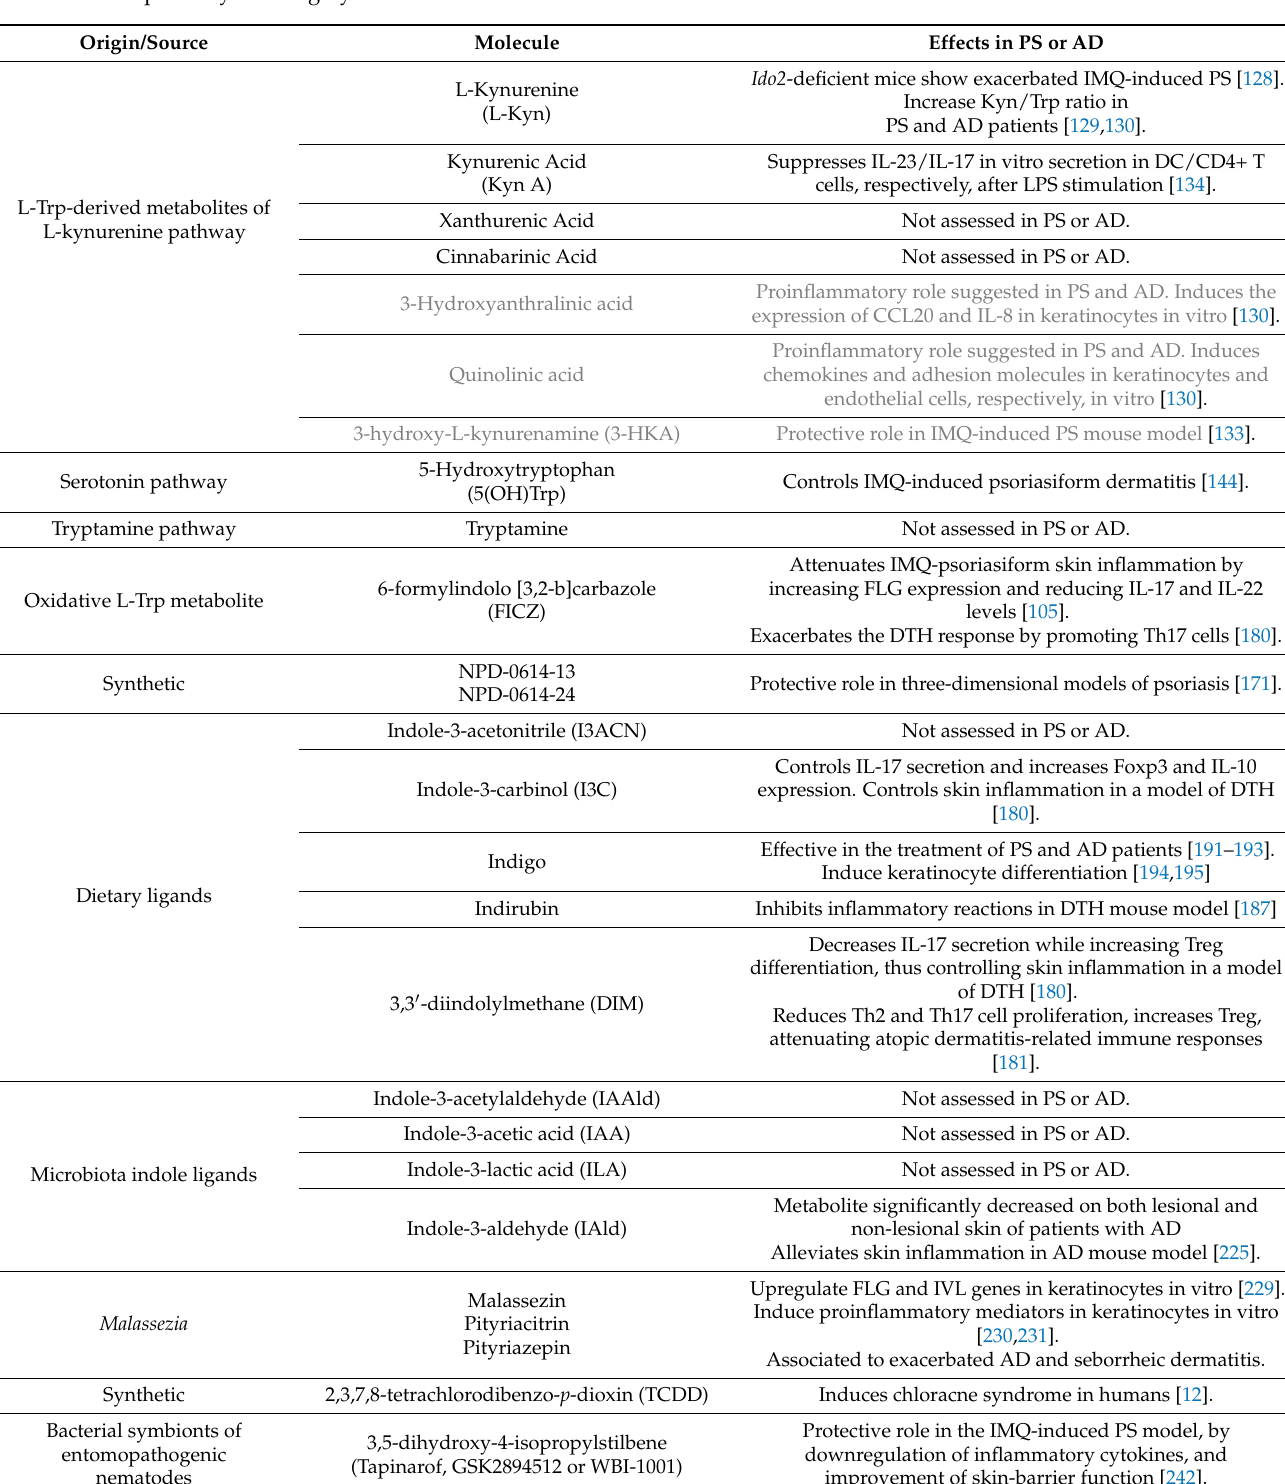
Table 1. Role of direct AHR ligands and intermediate L-Trp-derived metabolites in psoriasis (PS) and atopic dermatitis (AD). Molecules that have been proved to induce AHR transcriptional activity are in black, while intermediate molecules of metabolic pathways are in